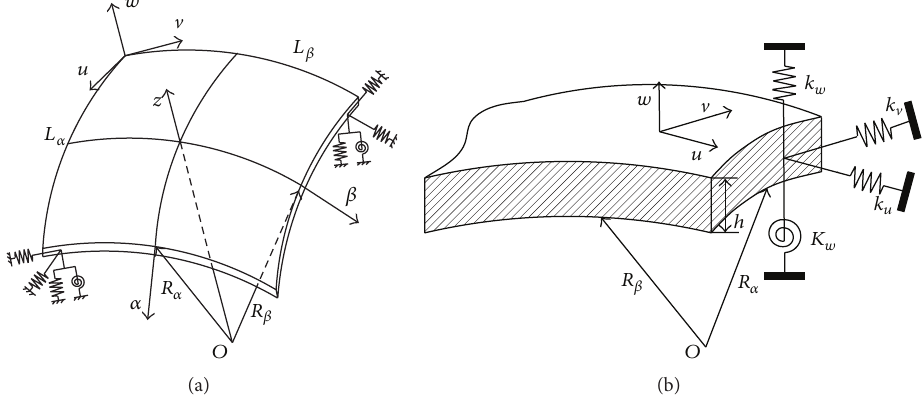
Figure 1: Geometry and notations of an open shell with elastically restrained edges: (a) coordinate system and (b) partial view.